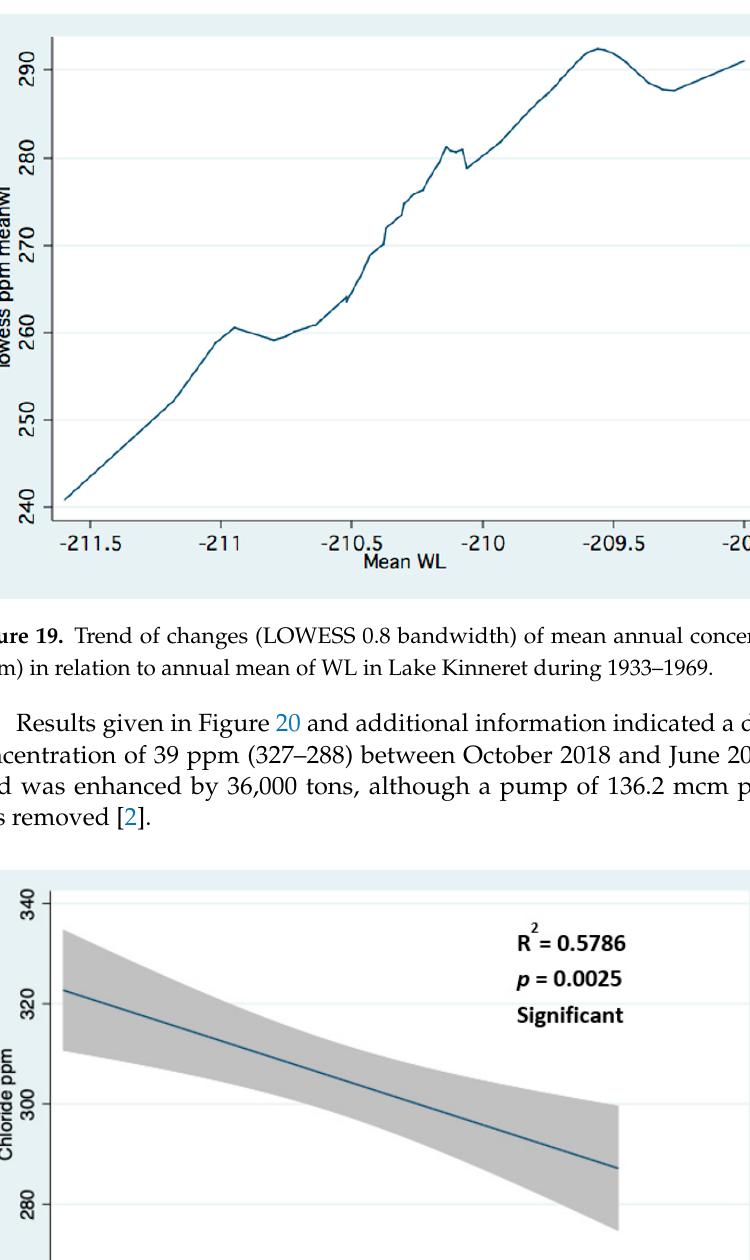
Figure 20. Linear regression (95% Cl) (r 2 and p values are given) between monthly means of chloride concentration (ppm) and salt load (10 3 tons) during the hydraulic year (October to next September), 2018–2019 (Data Source: Mekorot National Water Supply Co., Jordan districts, Laboratory and Drainage Basin Unit).